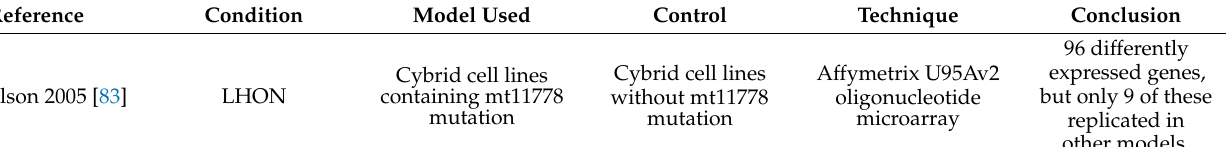
Table 1. Studies in the literature performing transcriptomic techniques in models of inherited optic neuropathy. Studies in glaucoma and mitochondrial disease in general have been reviewed [82]. LHON—Leber Hereditary Optic Neuropa- thy; OPA1 -DOA—Dominant Optic Atrophy caused by OPA1 mutations; RGC—Retinal Ganglion Cells;